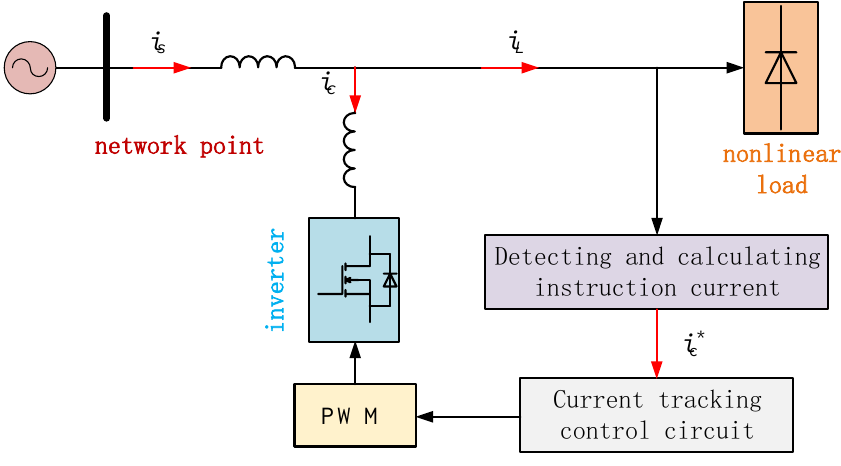
Figure 6. Basic principle diagram of active filter.